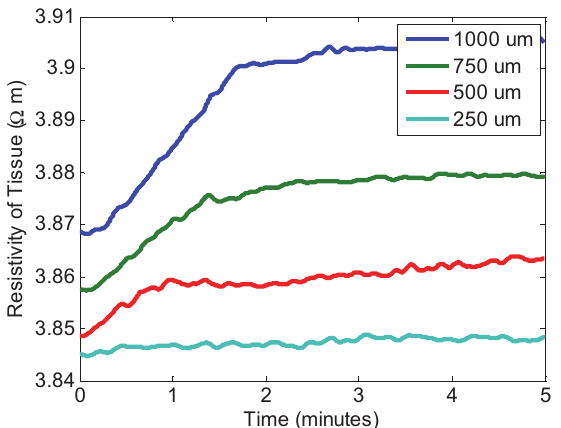
Fig. 12: Measured resistivity of acellular alginate during large strain indentation experiments calculated from eq. 32. Legend denotes final indentation depth.